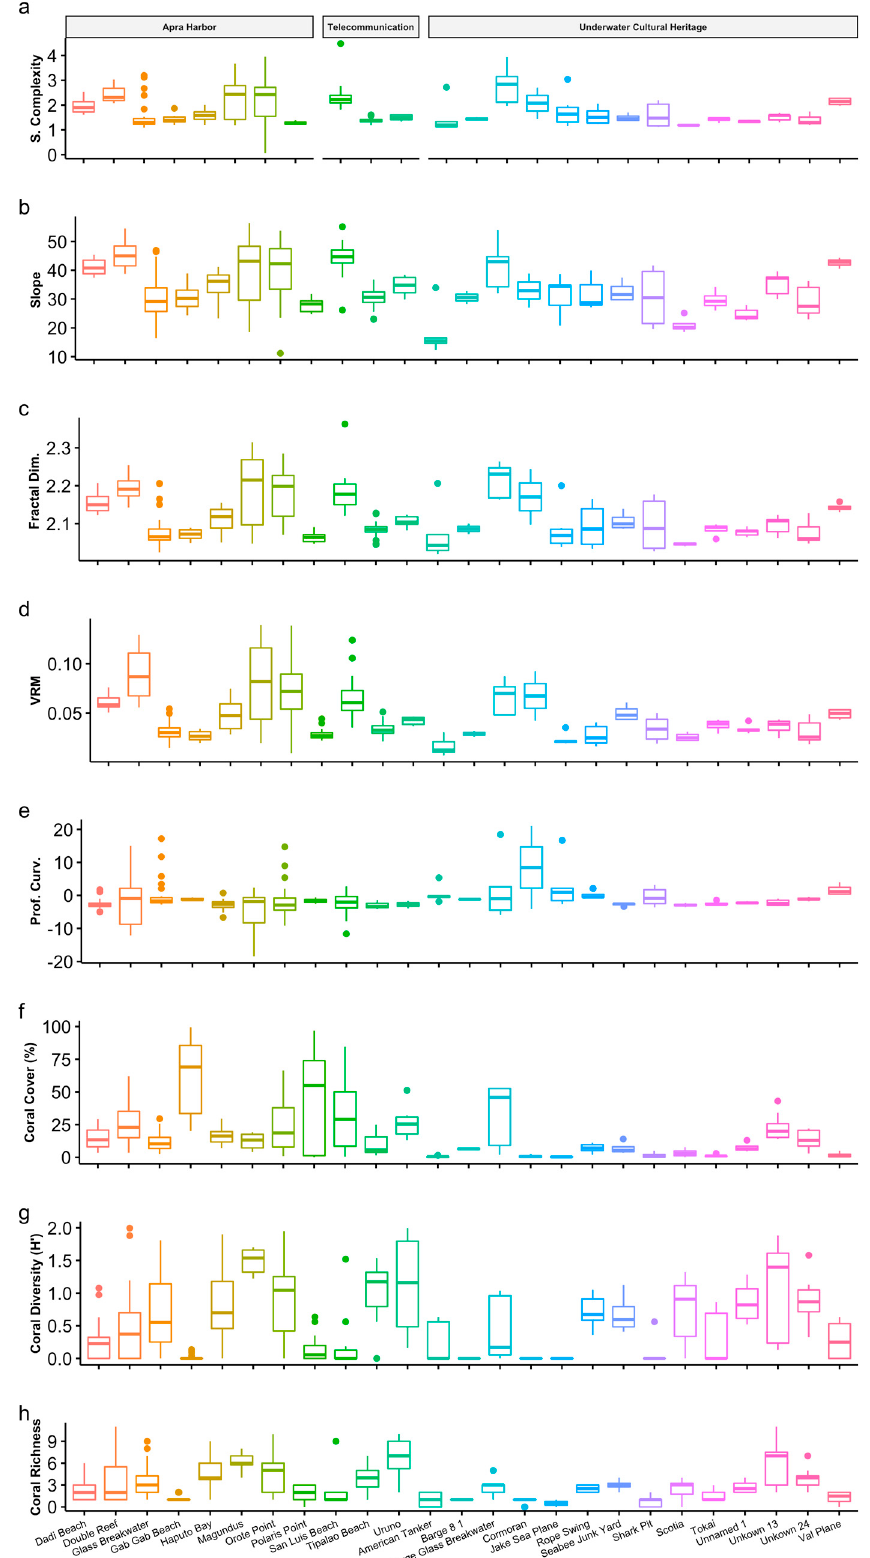
Figure 3. Comparison of 3D metrics of structural complexity ( a ) surface complexity, ( b ) slope, ( c ) fractal dimension, ( d ) vector ruggedness measure, and ( e ) profile curvature) and coral assemblage structure metrics ( f ) coral cover (%), ( g ) diversity (H’), and ( h ) richness) among all natural and artificial reef sites within the three study regions (AH, TS, and UCH).